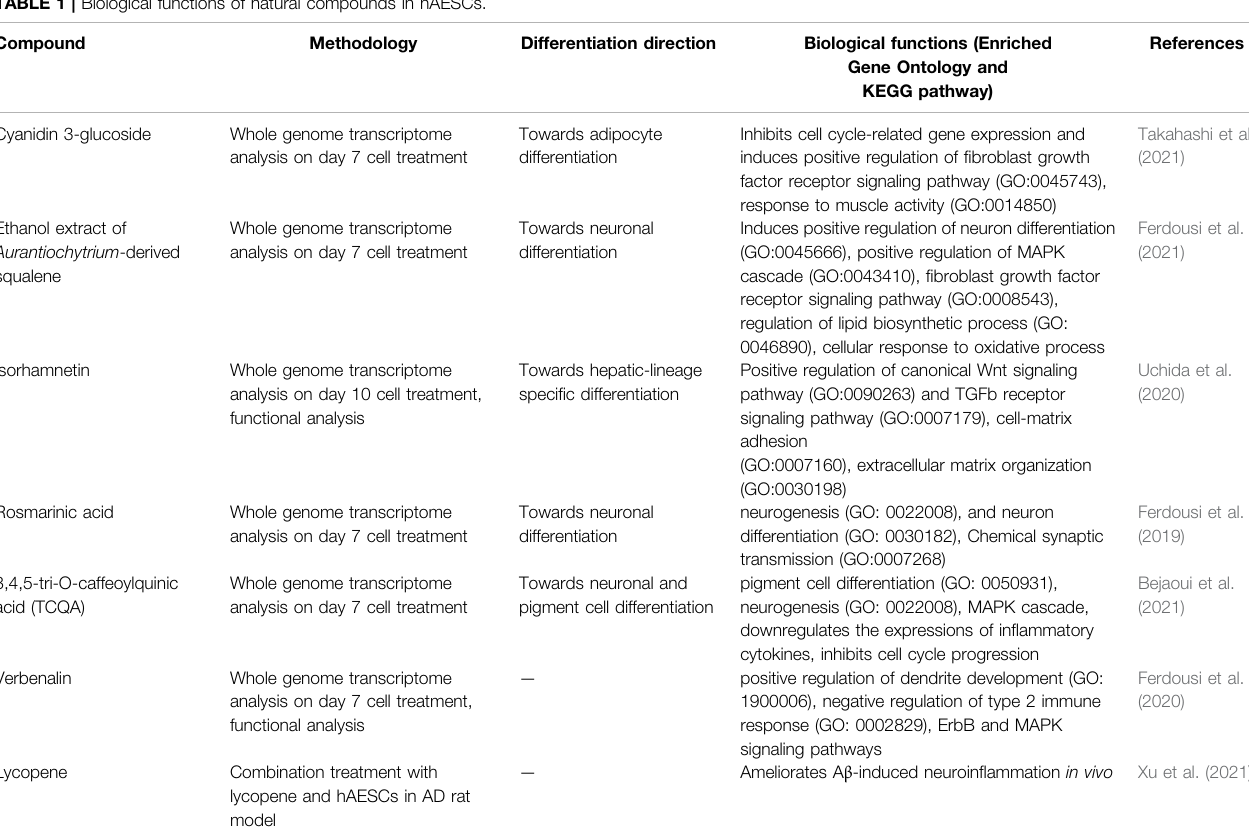
TABLE 1 | Biological functions of natural compounds in